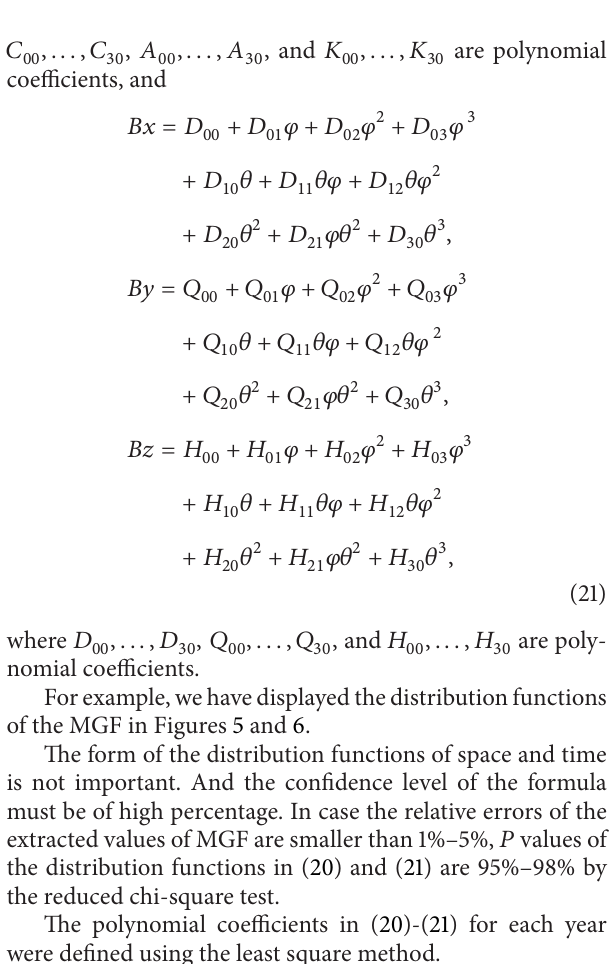
Figure 5: The MGF distribution functions in North America in